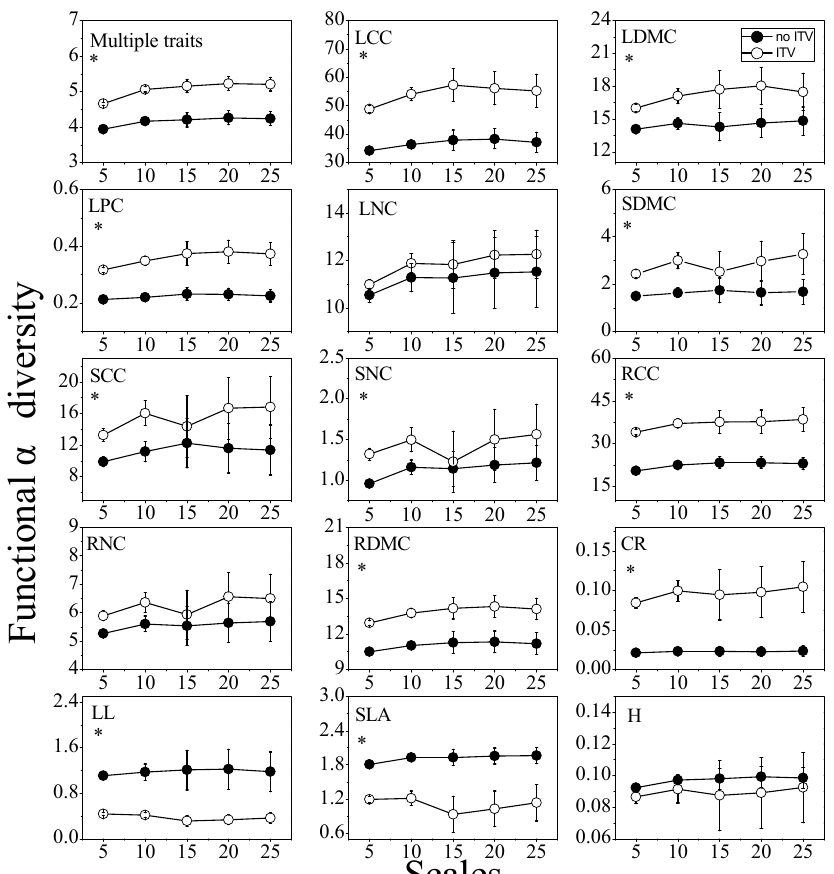
Figure 2. Influence of spatial scales and intraspecific trait variation (ITV) on the functional alpha diversity (mean ± SE). There are five spatial settings: 5 m × 5 m, 10 m × 10 m, 15 m × 15 m, 20 m × 20 m, 25 m × 25 m. The functional alpha diversity of multiple traits for different spatial scales is shown in the top left panel. Functional alpha diversity of single traits for different spatial scales are shown in their respective panels (including leaf carbon content (LCC), leaf dry matter content (LDMC), leaf phosphorus content (LPC), leaf nitrogen content (LNC), stem dry matter content (SDMC), stem carbon content (SCC), stem carbon content (SNC), root carbon content (RCC), root nitrogen content (RNC), root dry matter content (RDMC), canopy range (CR), leaf length (LL), specific leaf area (SLA), and height (H)). Hollow black point: including ITV; solid black point: not including ITV, * means p < 0.05.